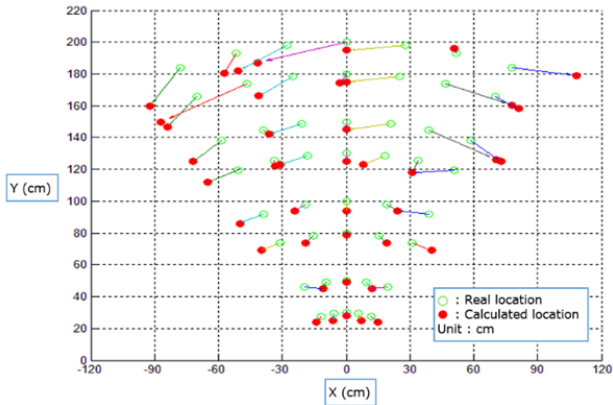
Figure 16. Location identification test result, with varying distances from the user.